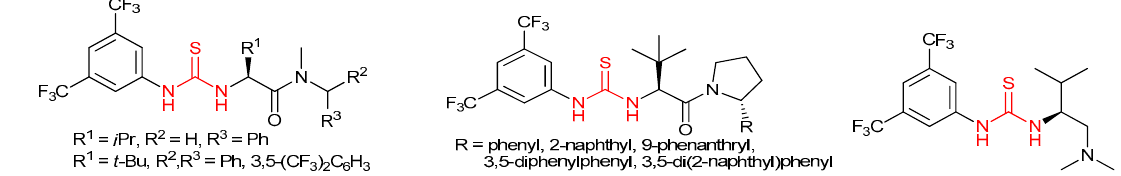
Figure 17. Examples of chiral thioureas derived from amino acids [263–269].